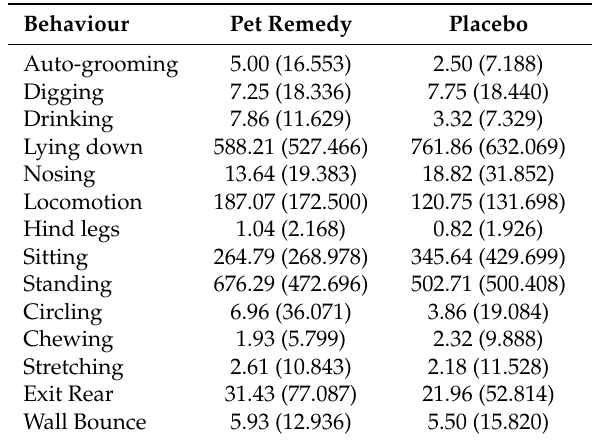
Table 2. The mean ( ± S.D.) duration (seconds) of each behaviour displayed by the dogs in the Pet Remedy and placebo conditions.